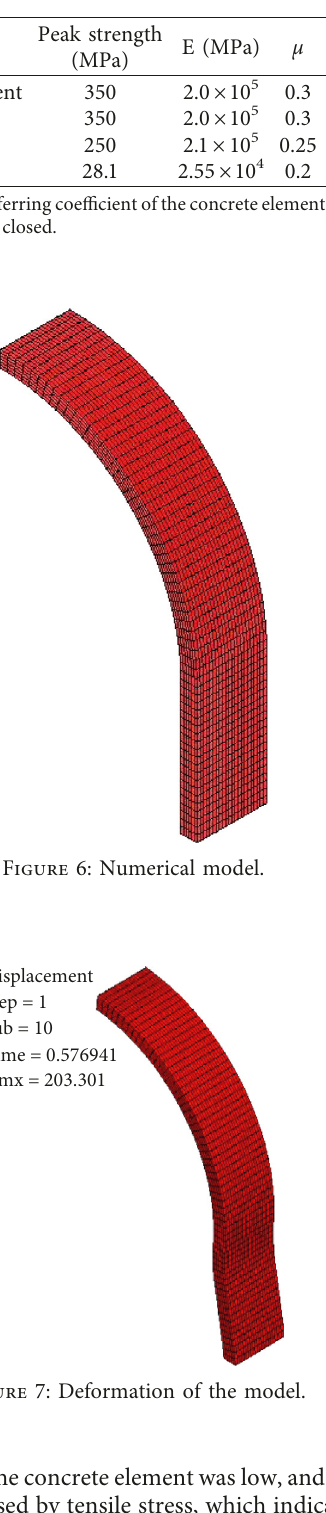
Table 1: Parameters used in the ANSYS numerical model.